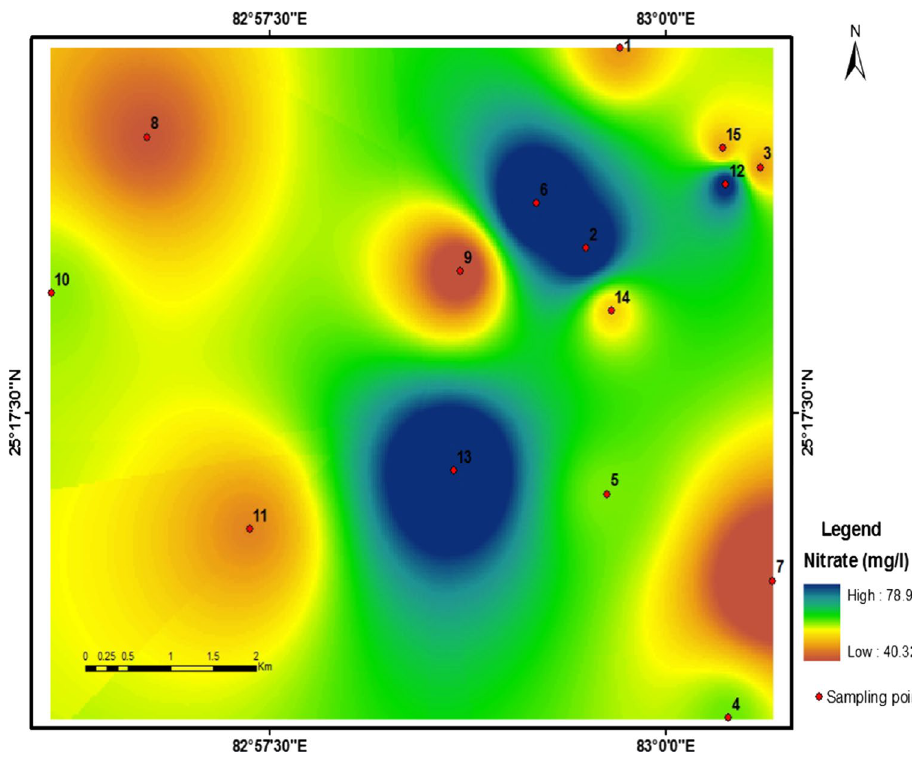
Fig. 2 Spatial distribution of nitrate in the study